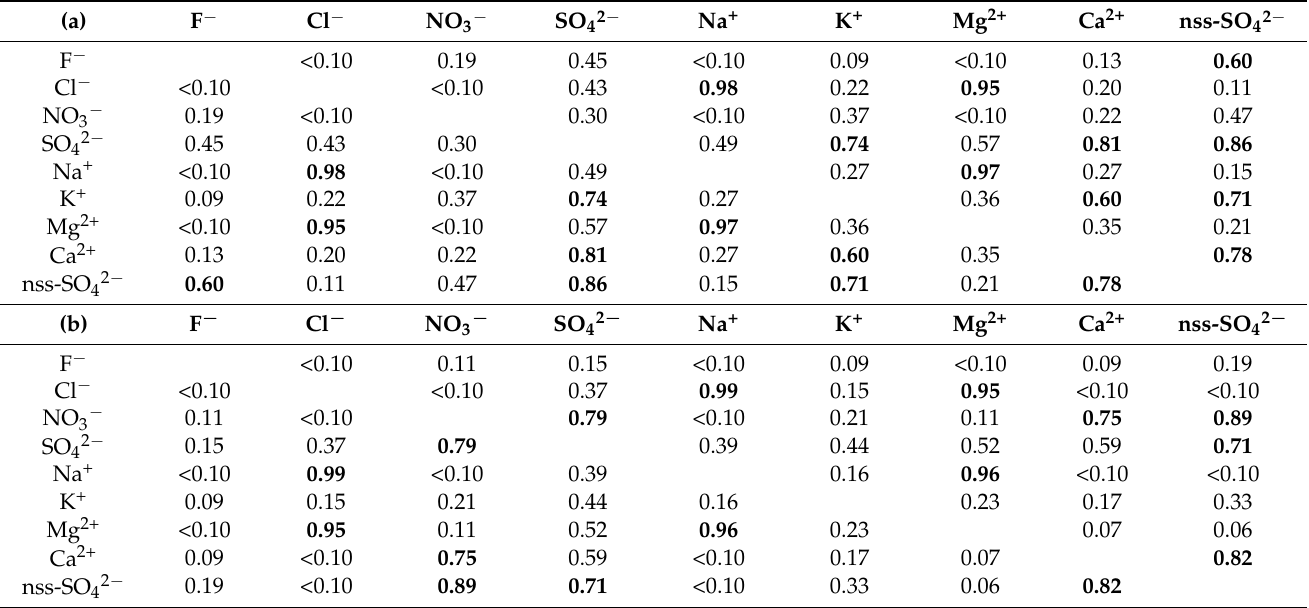
Table 3. The correlation coefficient between major ions for the Milazzo (a) and the Priolo Gargallo (b) bulk depositions. In bold the R 2 values ≥ than 0.60.